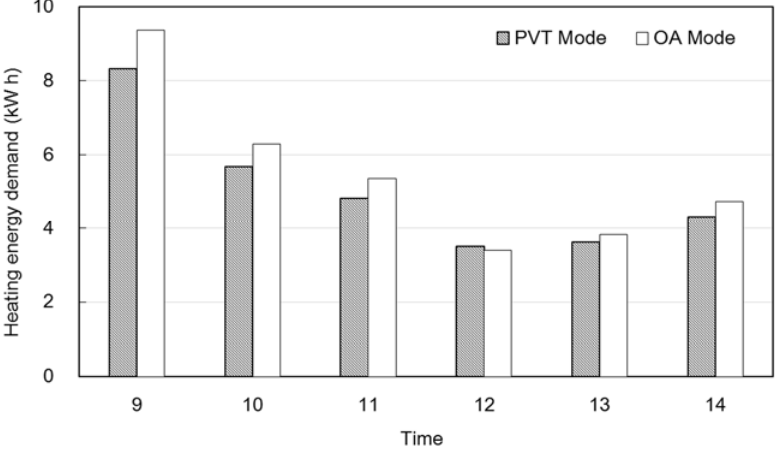
Figure 12. Heating energy demand for the experimental house in the two tested modes.